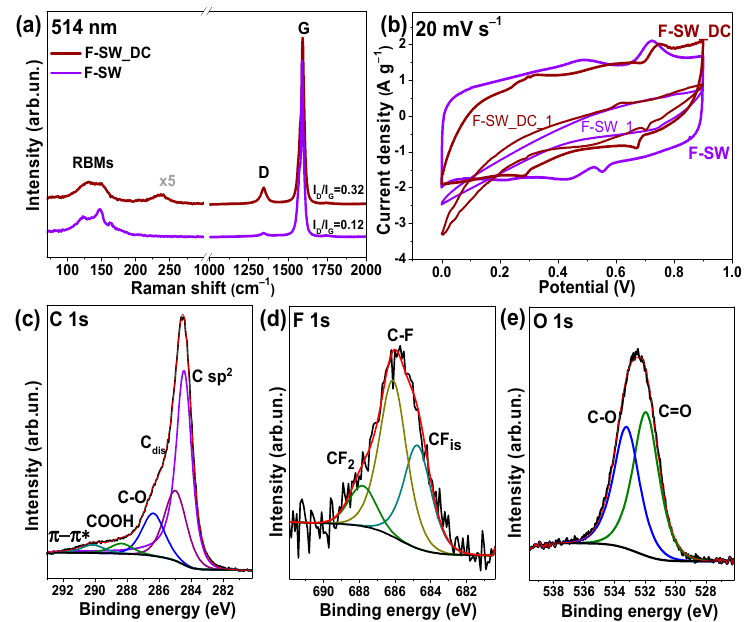
Figure 6. Raman spectra of F-SW and F-SW_DC films after long-term cycling ( a ). CV curves measured at a scan rate of 20 mV s − 1 vs. Ag/AgCl electrode for the starting films (F-SW_1 and F-SW_DC_1) and those after long-tern cycling ( b ). XPS C 1s ( c ), F 1s ( d ), and O 1s ( e ) spectra of the cycled F-SW film.